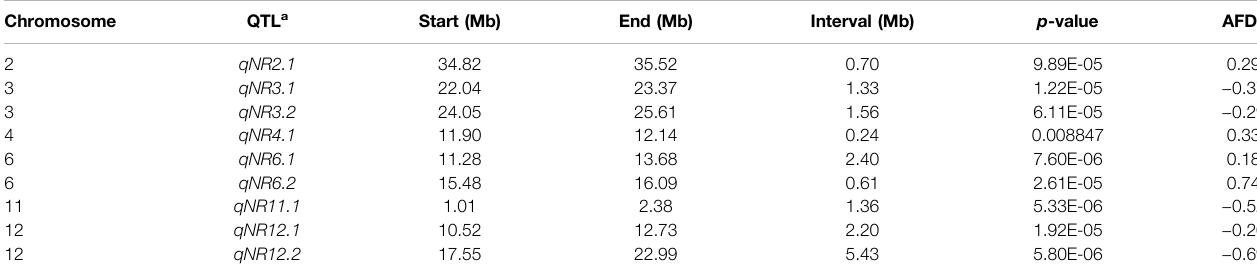
TABLE 5 | List of QTLs identi fi ed through BSA-seq for rice root-knot nematode ( M. graminicola ) resistance.